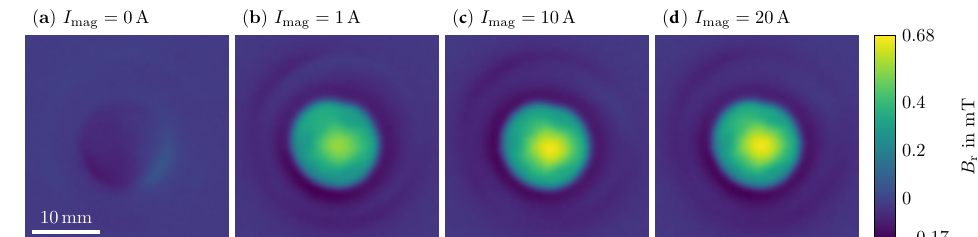
Figure 16. Two dimensional (2D)-surface scans of the residual magnetic flux density of sample 14 of MAT3 with increasing coil currents I mag in